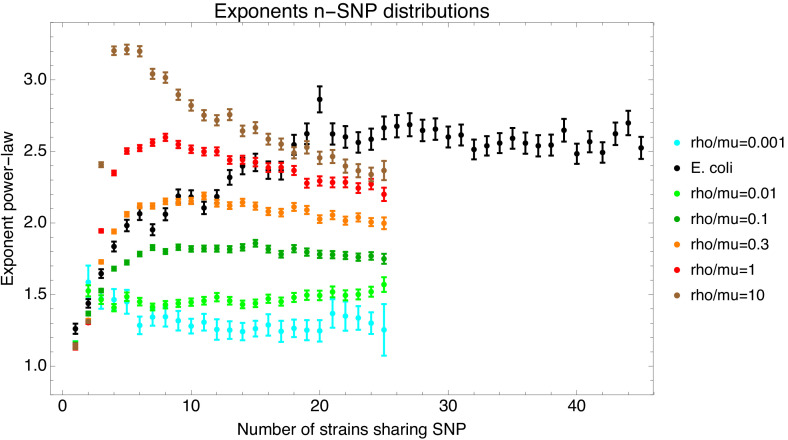
Fitted exponents of the n-SNP distributions for the E. coli data (black) and the data from the simulations with different recombination rates (colors, see legend).The bars show the fitted exponent plus and minus one standard-deviation of the posterior distribution.